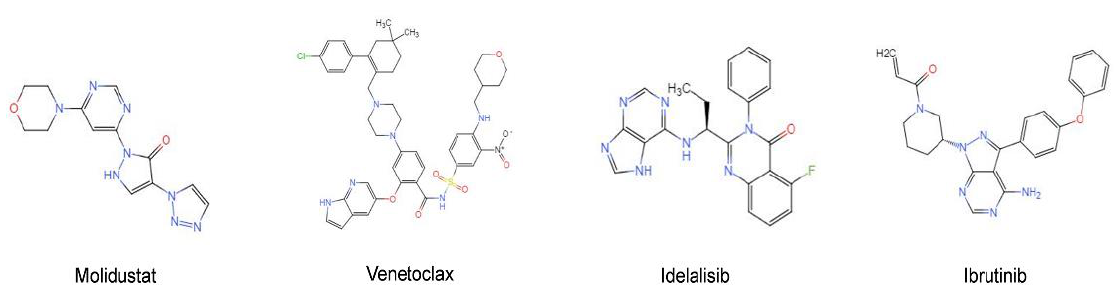
Figure 1. Chemical structure of Molidustat and other CLL targeted drugs.